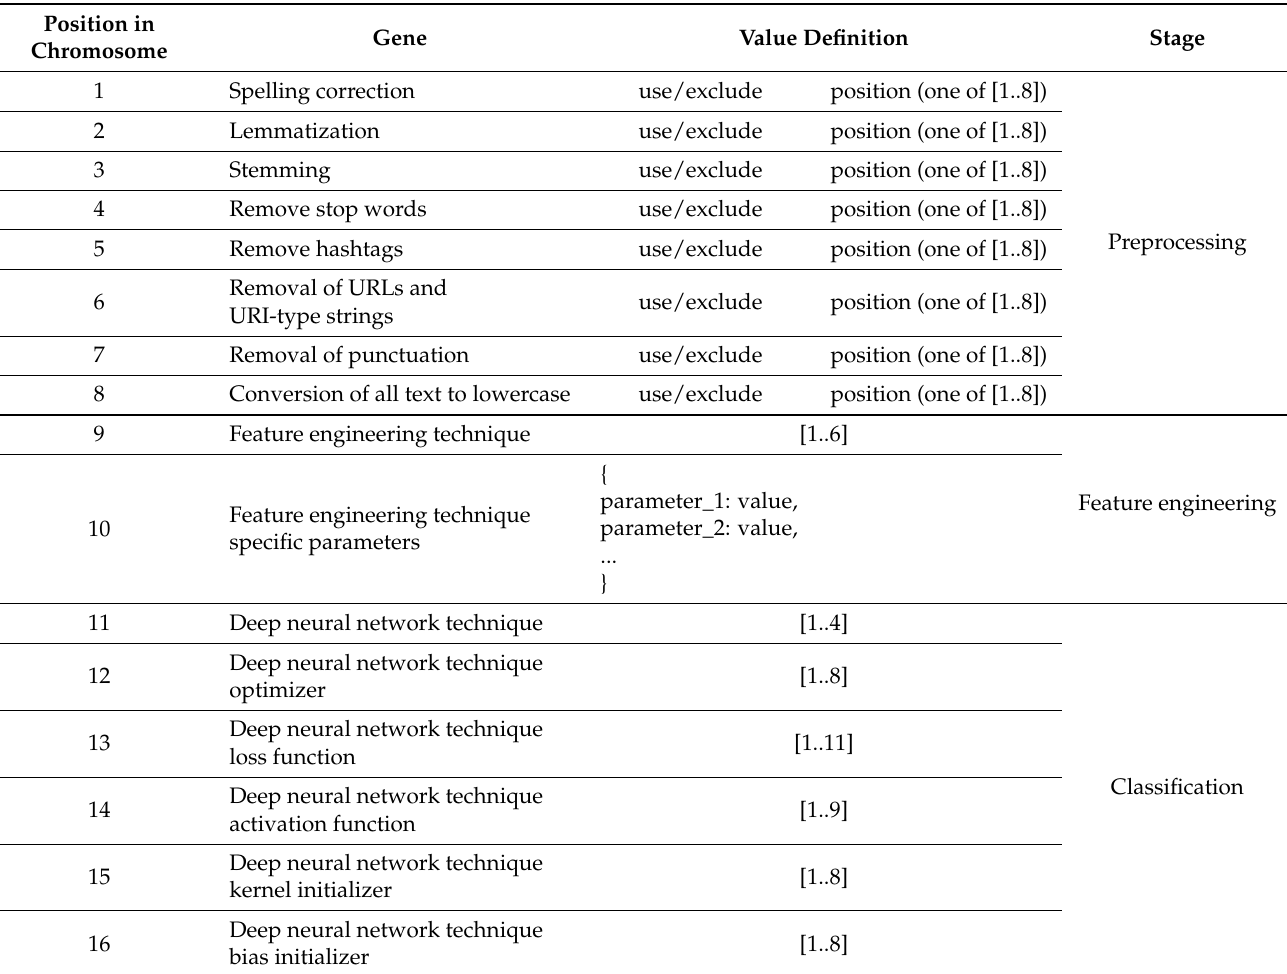
Table 2. Definition of the string representing the different designs decisions for a text process- ing